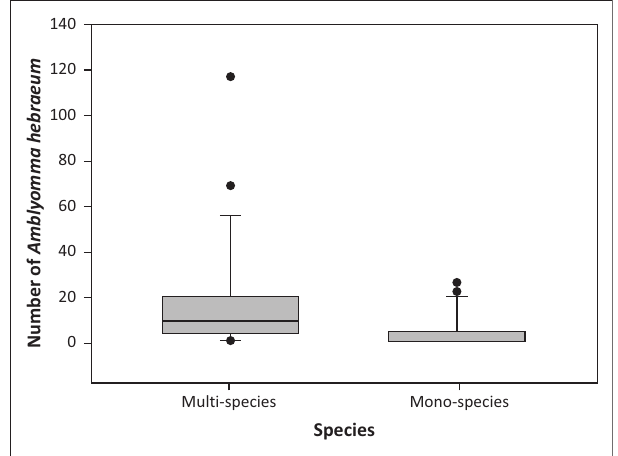
FIGURE 5: Boxplot depicting the number of Amblyomma hebraeum larvae collected from the vegetation in the woodland in the multi-species enclosure versus the sable antelope enclosures on the farm Hoopdal KQ96. The middle bar, the box and the whiskers refer to the median, the interquartile range and the interoctile (80 % ) range, whilst the dots are extremes or outliers.